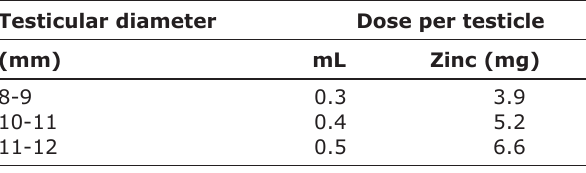
Table-1: Volume of zinc-based solution injected in the testes of rats according to testicular